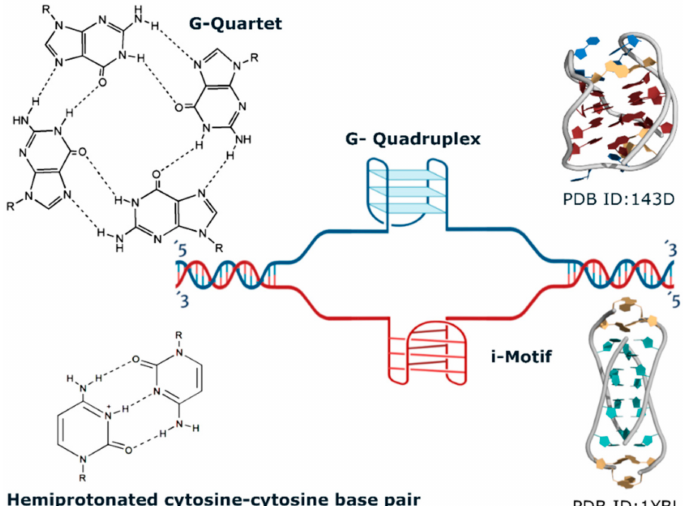
Figure 1. Schematic representation of DNA G-quadruplexes and i-Motifs. Top: G-quadruplexes (G4s) are formed within guanine-enriched regions of the genome. Four guanines bind through hydrogen bonding and arrange in-plane to form a G-quartet that stacks on top of each other to form a G4 (e.g., PDB ID 143D). Bottom: i-Motifs are formed in a cytosine enriched region via hydrogen bonding of hemiprotonated cytosine–cytosine base pairs (e.g., PDB ID